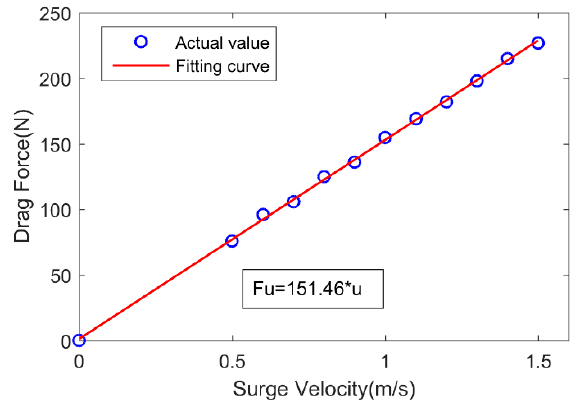
Figure 7. Relationship of surge velocity and drag force in surge direction for USV.